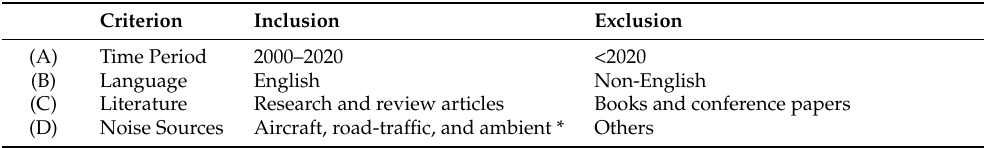
Table 2. Defined inclusion and exclusion